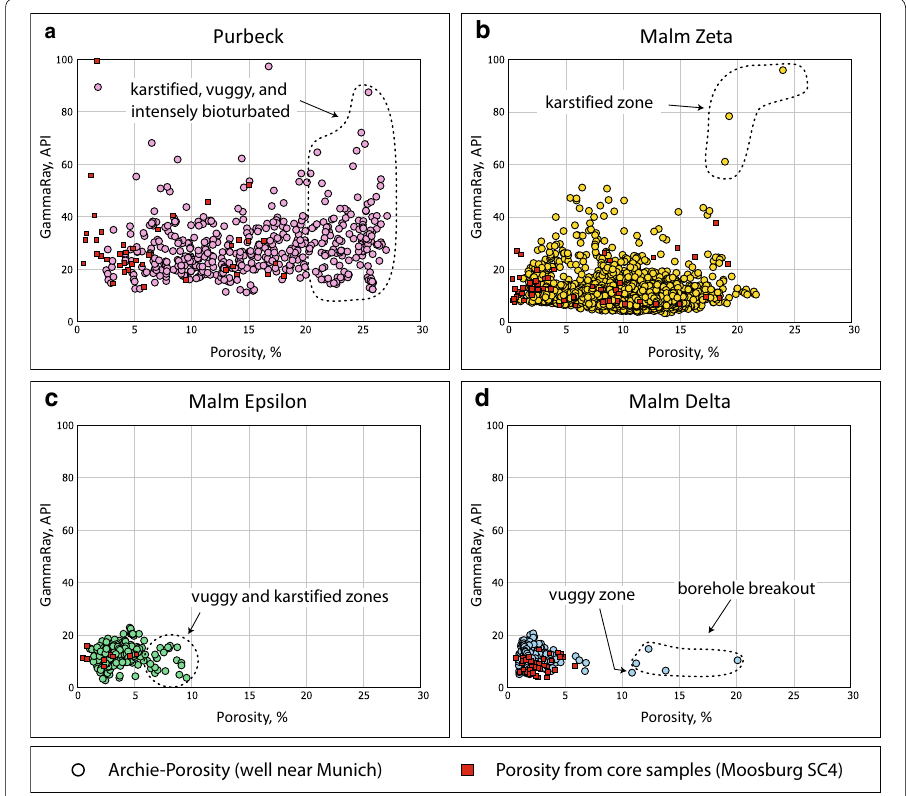
Fig. 15 Correlation of the porosity data from rock cores (Moosburg SC4) to calculated Archie porosity from the downhole deep resistivity log of a geothermal well in the area of Munich. By subdivision of data into the stratigraphic intervals Purbeck ( a ), Malm Zeta ( b ), Malm Epsilon ( c ) and Malm Delta ( d ), almost similar distributions of porosity can be found for both boreholes. Note that Archie porosity represents total porosity of the reservoir rock including isolated pores and secondary porosity (vugs,